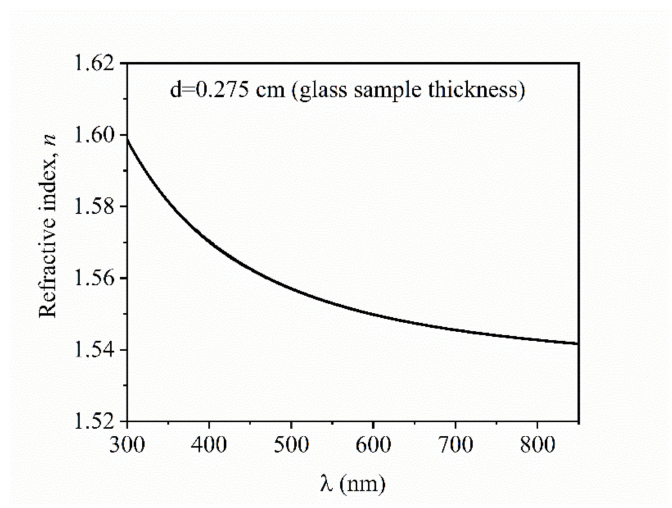
Figure 4. The refractive index versus wavelength for the Te-5